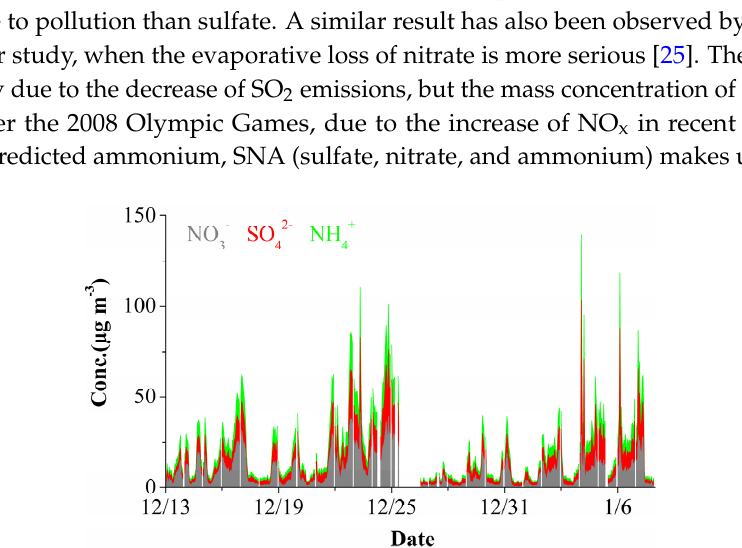
Figure 4. Variation of SO 42 − /CO, NO 3 − /CO, SOR, and NOR with pollution level. The “C”, “SP”, and “P” in the figure refer to “clean”, “slightly polluted”, and “polluted” respectively. The mean (pentagram), median (horizontal line), 25th and 75th percentiles (lower and upper box), and 10th and 90th percentiles (lower and upper whiskers) are shown for each bin. The potential sources of sulfate and nitrate are also evaluated in our study. Mass ratios of NO 3 − /SO 42 − are extensively used to assess the relative importance of mobile versus stationary pollution sources of sulfur and nitrogen in the atmosphere [29,30]. For all datasets in our study, Ep1, Ep2, and Ep3, an increasing trend of mass ratios of NO 3 − /SO 42 − is found from clean periods (0.8) to polluted periods (1.5), indicating the enhanced contribution of vehicle emissions to haze formation. For the entire study, the average mass ratio of NO 3 − /SO 42 − is 1.28, much higher than that observed in other regions of China [26,30]. In addition, the NO 3 − /SO 42 − mass ratios monitored in the same sampling site as this study in 2000 and 2002 are 0.58 and 0.78, respectively [31,32]. The significant increase of NO 3 − /SO 42 − mass ratio in Beijing from 2000 to 2013 reveals that the relative importance of motor vehicles to PM pollution may rise largely during the past years. Meteorological conditions have a strong impact on pollution level. Compared to clean periods, polluted periods are characterized with lower temperature, higher relative humidity, and lower wind speed (Figure 5). The relatively low temperature and wind speed would favor the accumulation of chemical pollutants. The high relative humidity in polluted episodes would accelerate the formation of sulfate and nitrate through the oxidation of SO 2 and NO 2 in aqueous phase. This is further proved by the strong correlation of sulfate and nitrate with relative humidity ( r = 0.65 and 0.56 respectively).